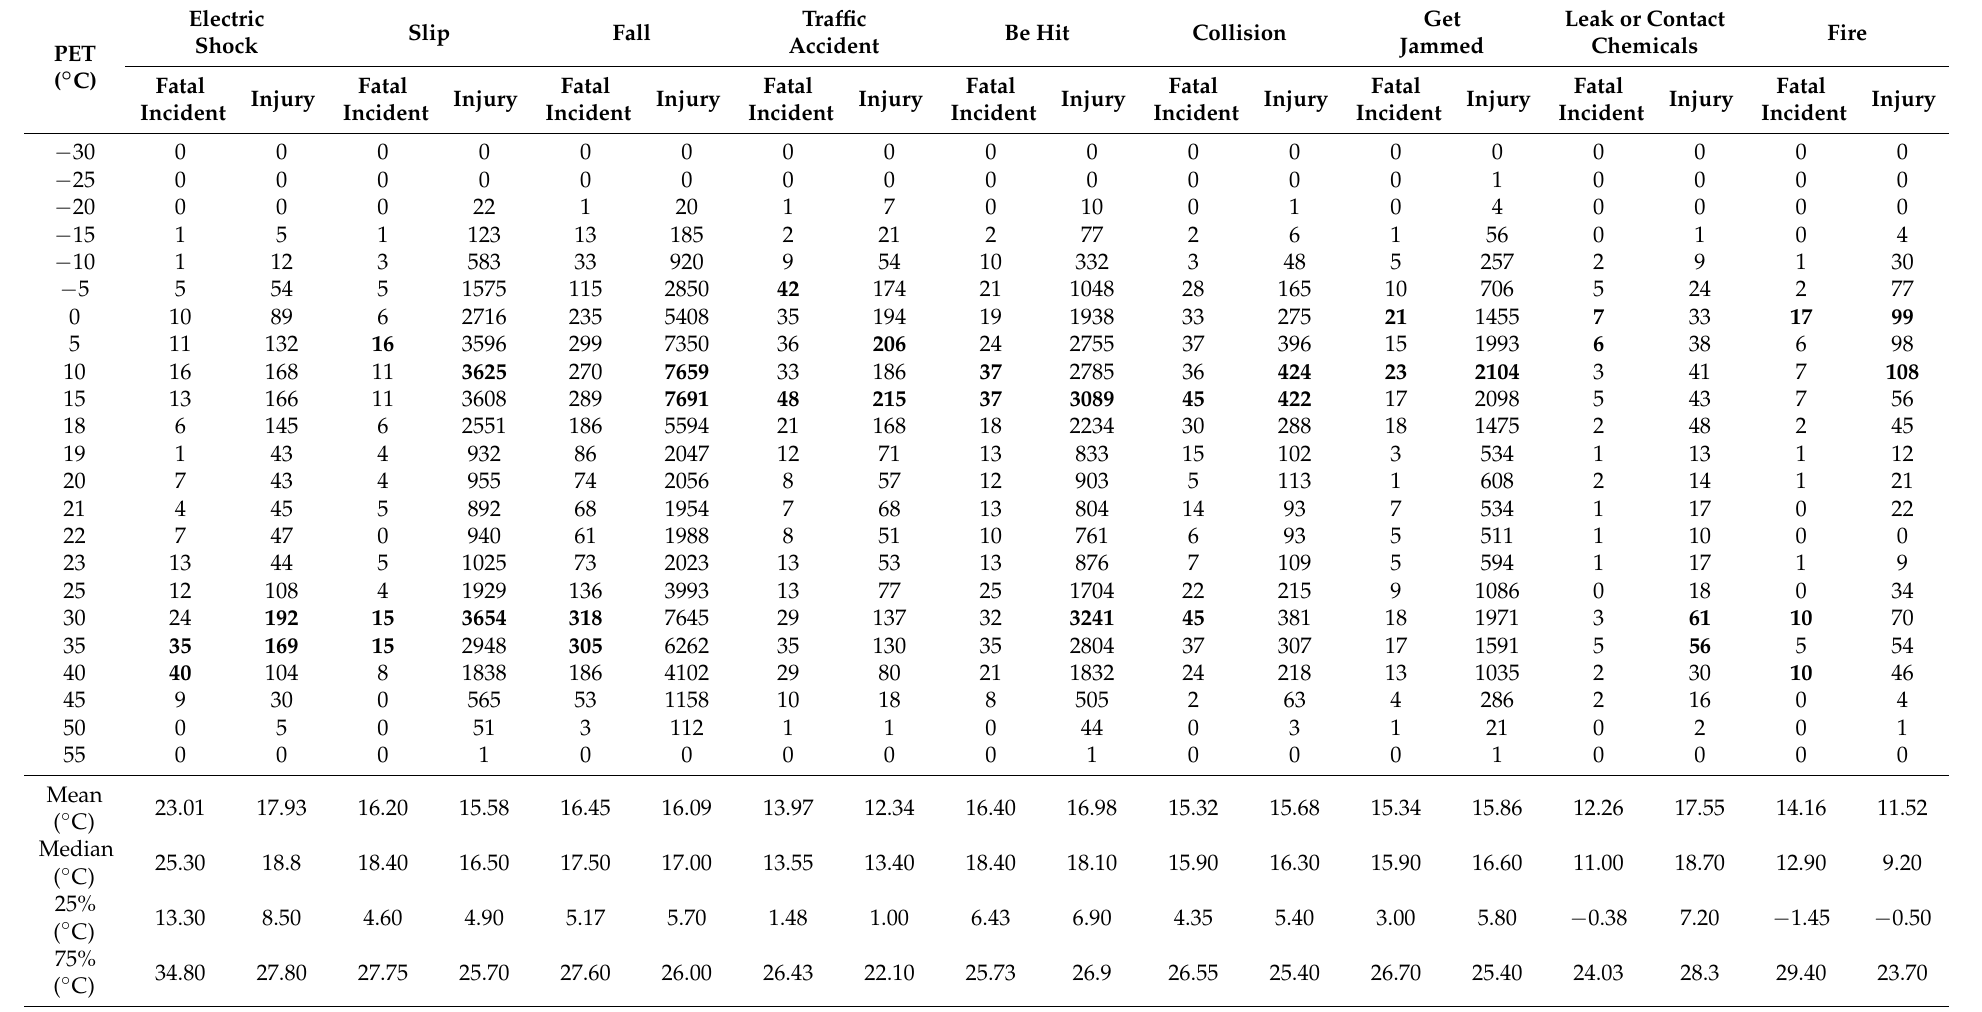
Table 7. Distribution of injury and fatal accidents in terms of the PET